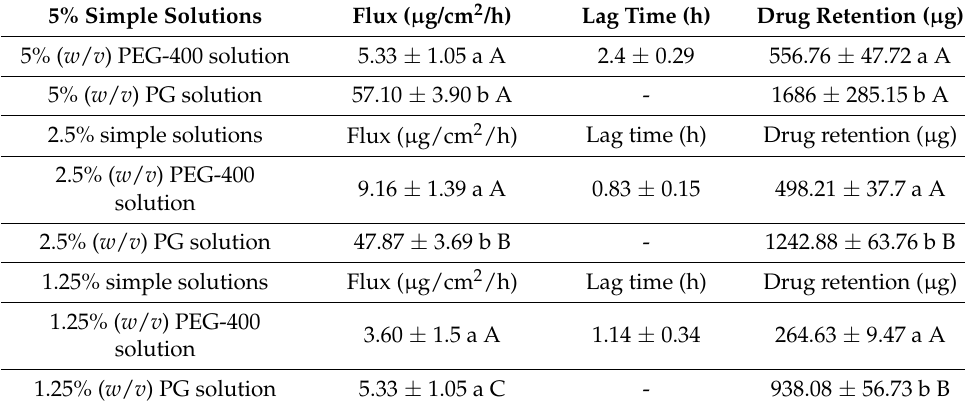
Table 3. In vitro drug membrane parameters of resatorvid topical simple solutions through Strat-M ® transdermal diffusion membrane ( n = 3, mean ± standard deviation). Lowercase letters indicate differences between formulations with the same concentration. Capital letters indicate differences between concentrations in the same formulation ( p <